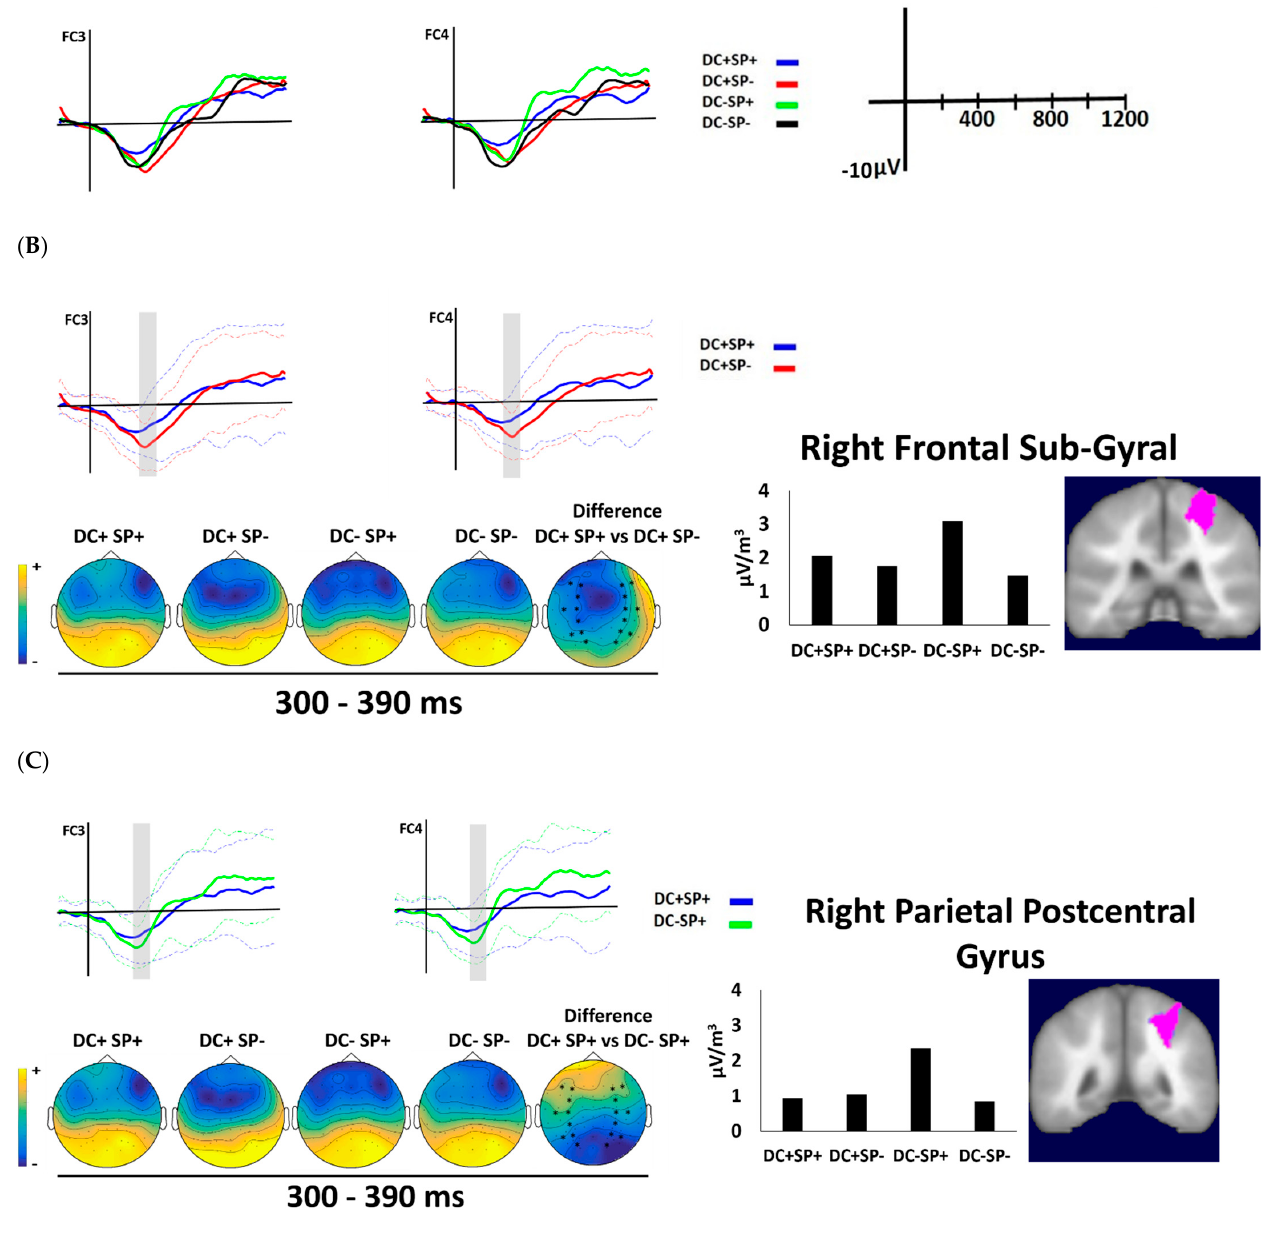
Figure 3. ( A ) Grand average waveforms for congruous duration (DC+) and incongruous duration (DC − ) and semantically predictable (SP+) and unpredictable (SP − ) sentences for the four experi- mental conditions at FC3 and FC4 as function of metric task. ( B ) Grand average waveforms of N400 component for DC+ SP+ and DC+ SP − contrast conditions and ( C ) DC+ SP+ and DC − SP+ contrast conditions. The time windows with a contrast are indicated in gray. The dotted lines indicate the standard deviations. Left: spatial distributions resulting from the comparison between the condi- tions. The asterisks at the topographical maps show the used electrodes. Right: current density val- ues for the contrast and their brain spatial localization for the semantic contrast (rFSG) and duration contrast (rPG).